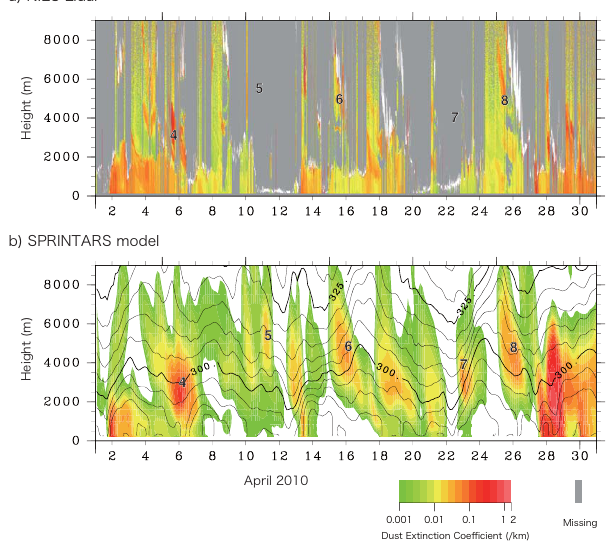
Fig. 1. Time-height cross-section of the dust extinction coefficient at Matsue (35.3 ◦ N, 132.7 ◦ E), Japan, in April 2010. (a) NIES lidar observation, (b) SPRINTARS simulation with potential temperature (contour). Numbers show the model-identified dust episode (shown in Fig.